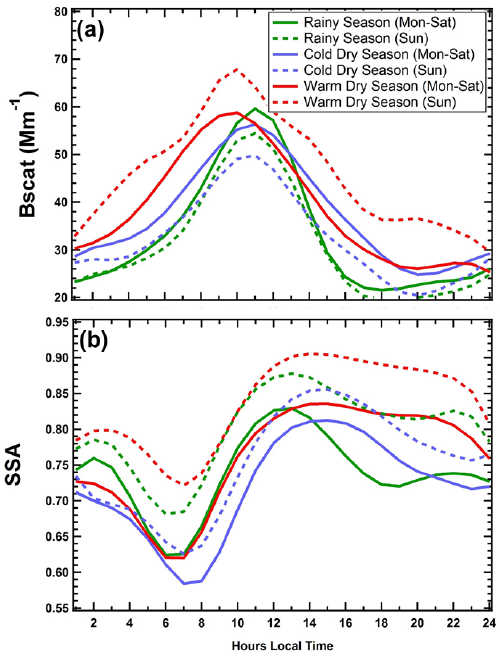
Figure 10. As in Figs. 8 and 9 but for (a) the light-scattering coef- ficient, Bscat, and (b) the single scattering albedo, SSA.